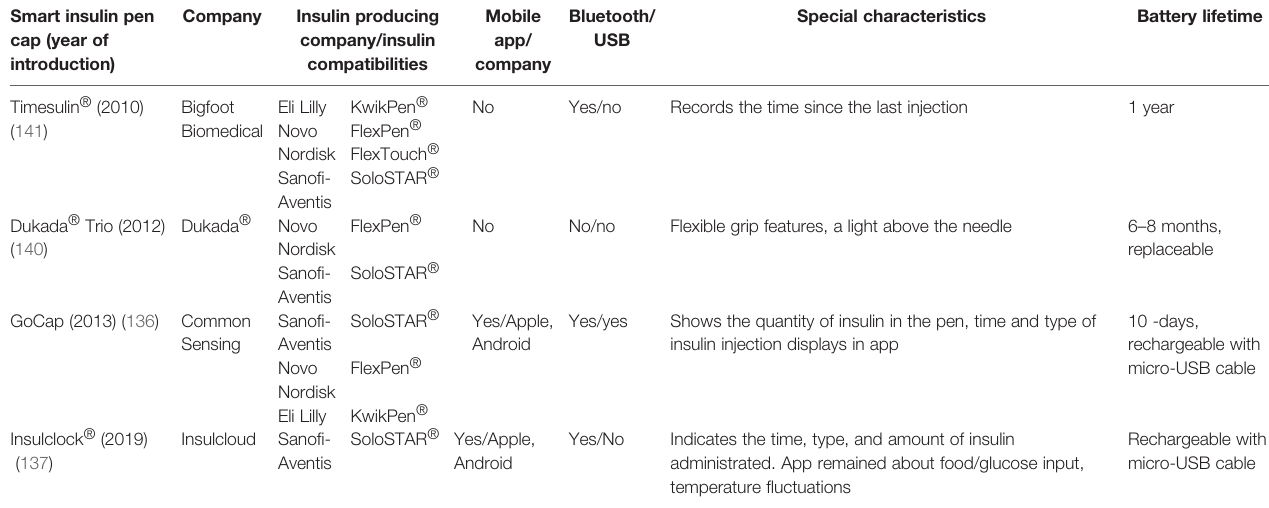
TABLE 8 | Technical characteristics of insulin pen